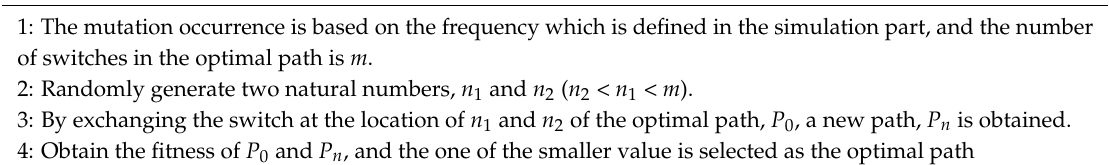
Procedure 2. Mutation operation of G-ACO